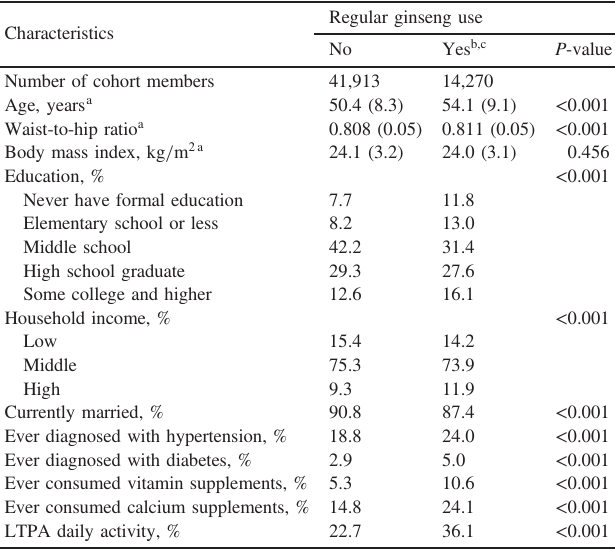
Table 1. Selected baseline characteristics of study participants by ginseng consumption status, Shanghai Women ’ s Health Study, 1996 –